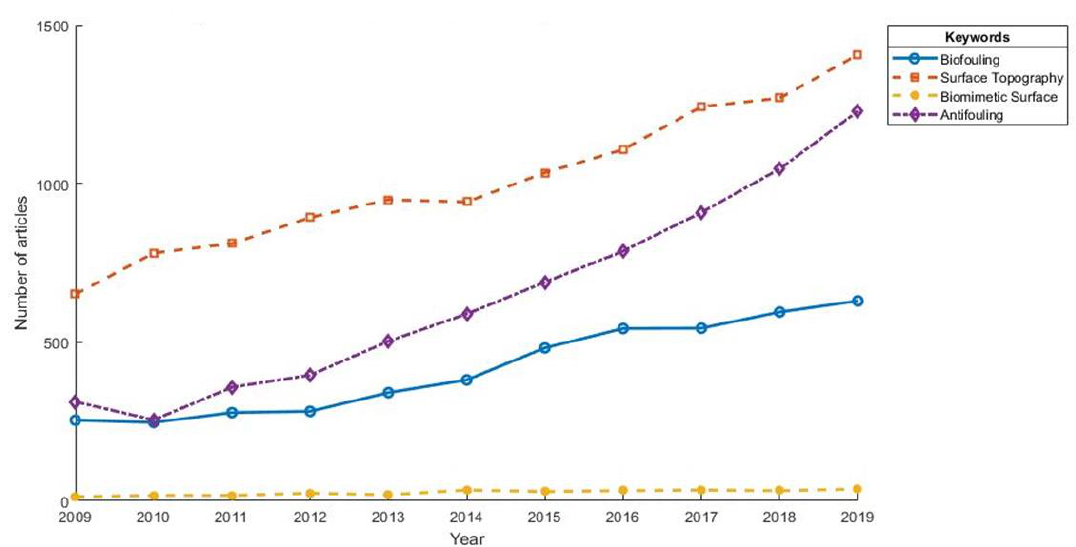
Figure 1. Comparison of the research trends of keyword selected articles from 2009–2019 indexed by Web of Science.